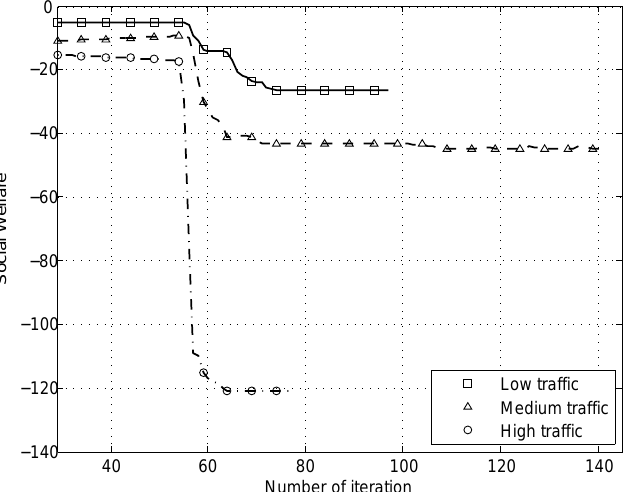
Figure 4. Evolution of social welfare for a bigger market of N = 4 operators and M = 15